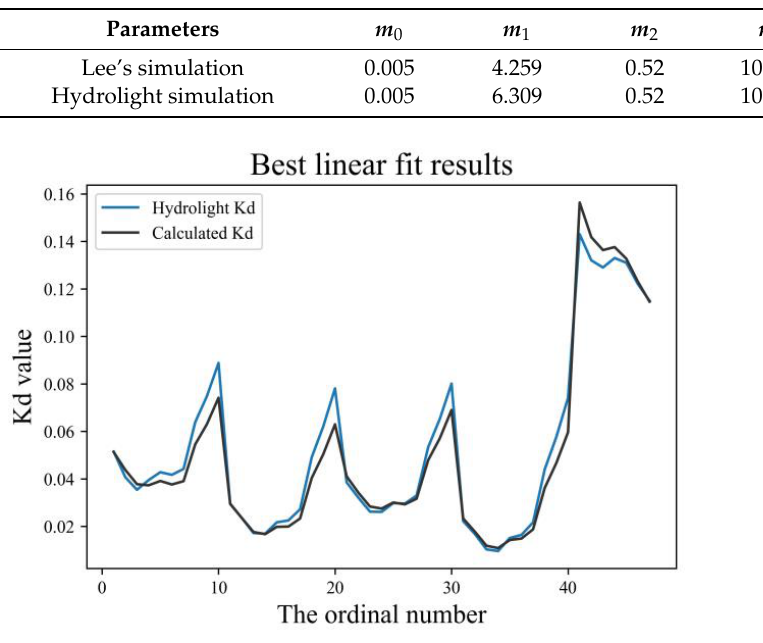
Table 8. Hydrolight simulation results.